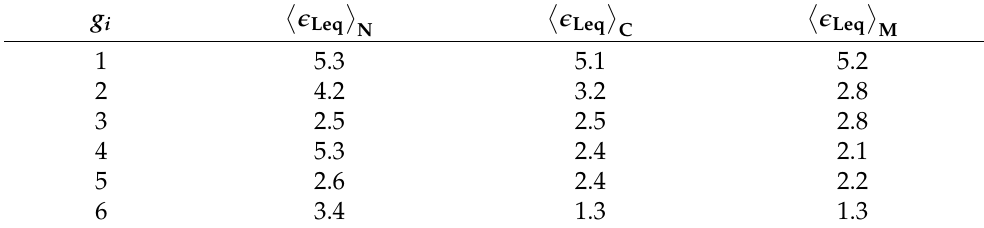
Table 7. Mean group deviations (in dB) of Dynamap predictions from measurements, for groups (cid:10) (cid:11) (cid:101) Leq ( g 1 − g 6 ). Here, are the deviations obtained without systematic error corrections, N those obtained with systematic error corrections, and predictions [91]. g